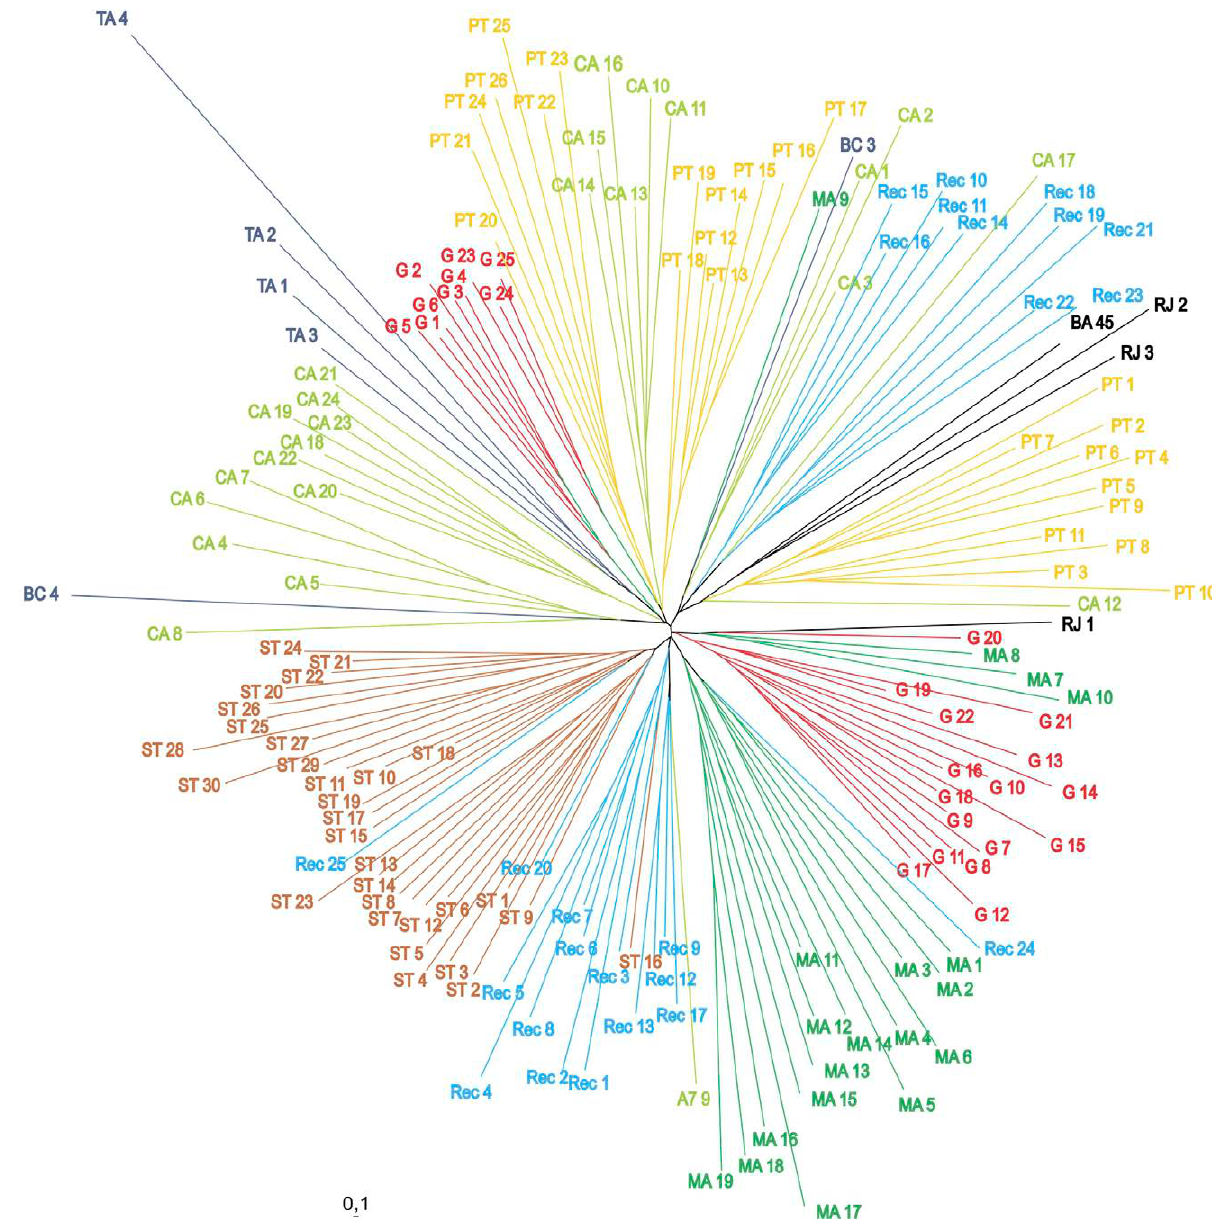
Figure 3. Neighbor-Joinning topology from Tropidurus hispidus specimens for ISSR markers. See Table 1 and text for